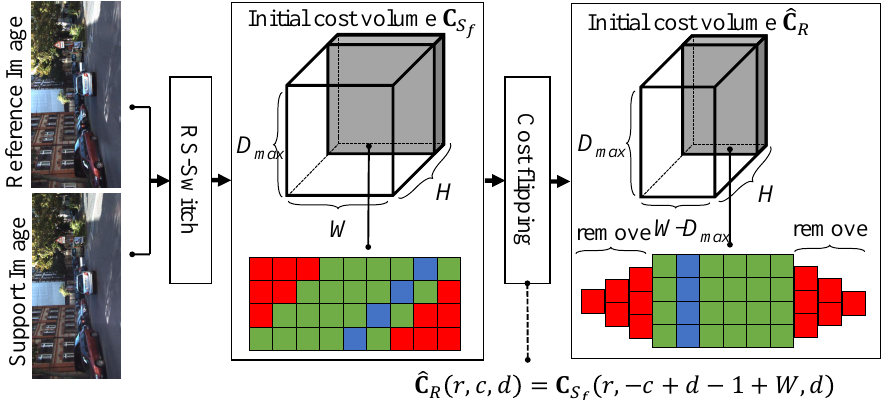
Figure 3. Illustration of initial cost volume consistentization, which consists of RS-Switch and cost flipping. The removed and active regions are marked in red and green, and the cost pillar is displayed in blue.